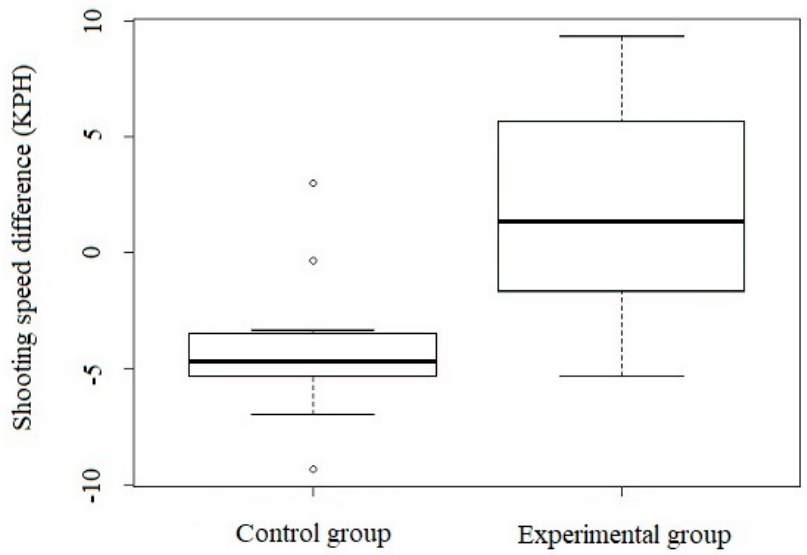
Figure 4. Changes in shooting speed before and after the intervention (control group n = 15, experi- mental group n = 15); horizontal line in the box = median; vertical line = data variability outside the upper and lower quartiles. Intermittent points indicate outliers. Table 2. Speed and accuracy of shooting: average values at the beginning and after 8 weeks of intervention—experimental group and control group.